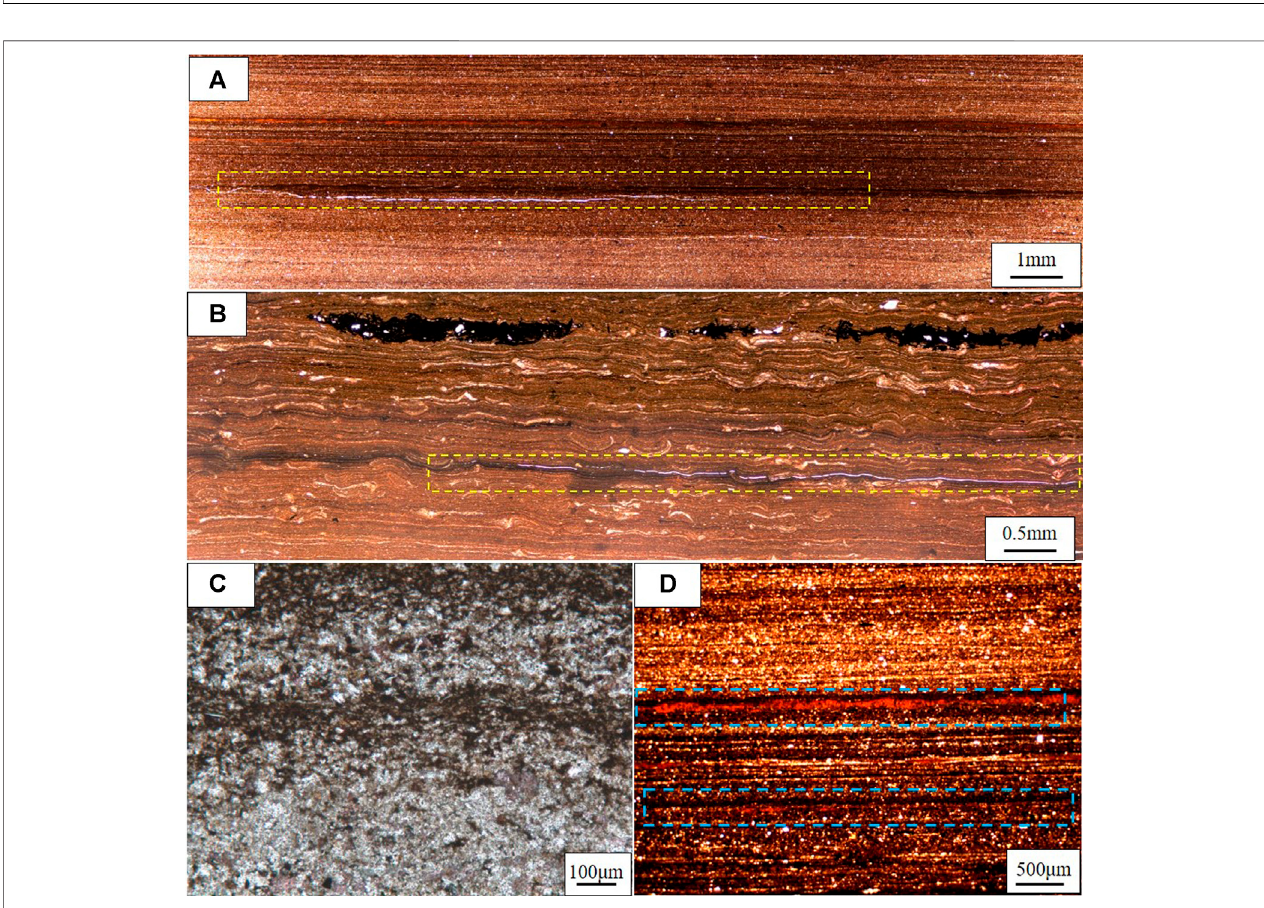
FIGURE12| Microcracks candevelop betweenclayminerals (A,B) ,and cementation ofcalcite mineralmake therock moretight (C,D) . (A) : GD12,3,880.9m; (B) : G108-8, 3,040.6m; (C) : G108-8, 3,043.5m; (D) : GD14, 4,135.5 m.